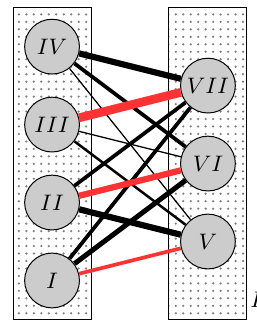
Figure 3: A bipartite graph. The set of nodes are separated into two subsets { L, P } in a way that edges are restricted to relations between these two subsets. The edge labels µ are depicted as the thickness. A possible bipartite matching is marked in